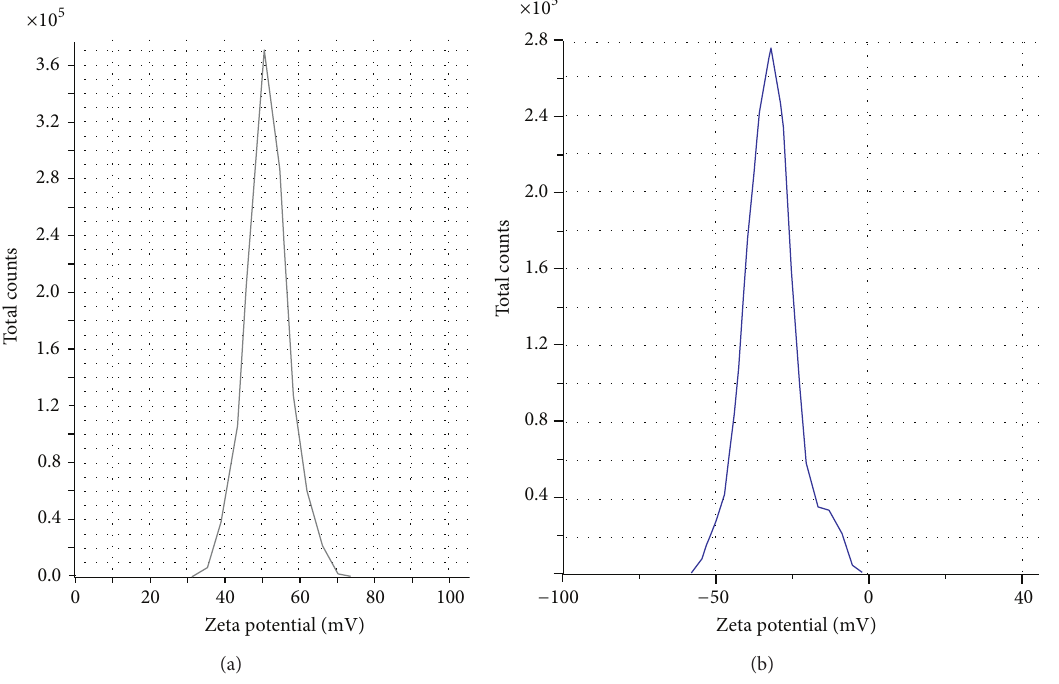
Figure 4: Zeta potential measurement of (a) CS-CuO hybrid and (b) CuO at pH 7.